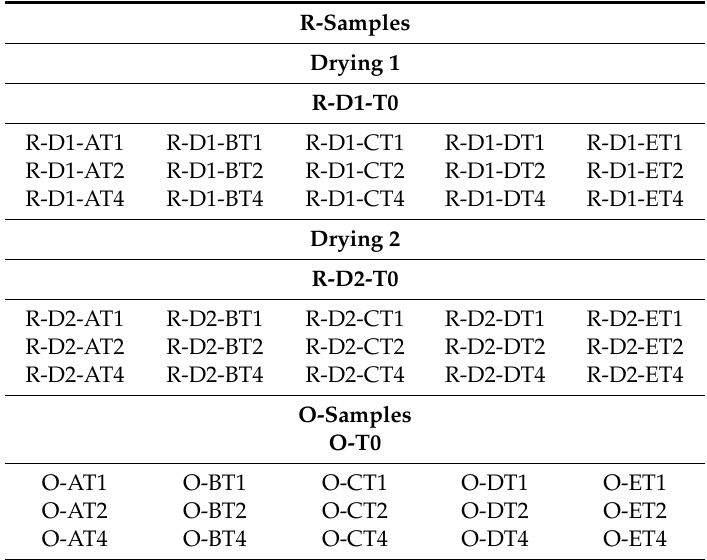
Table 1. O-samples and R-samples.